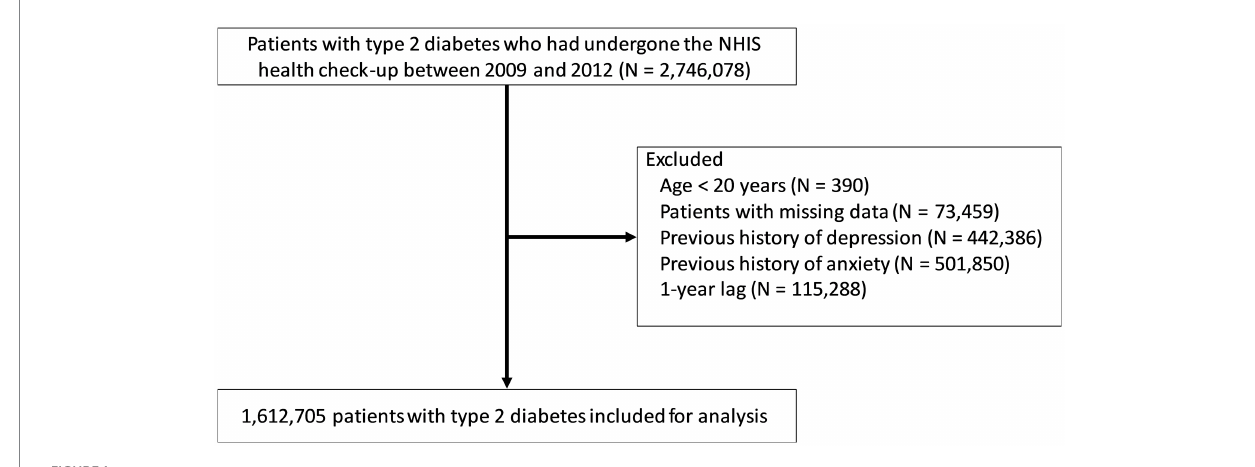
FIGURE 1 Selection of the study population. NHIS, National Health Insurance